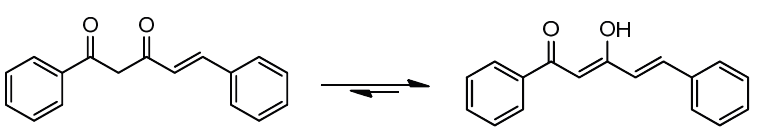
Figure 2. General structure of target